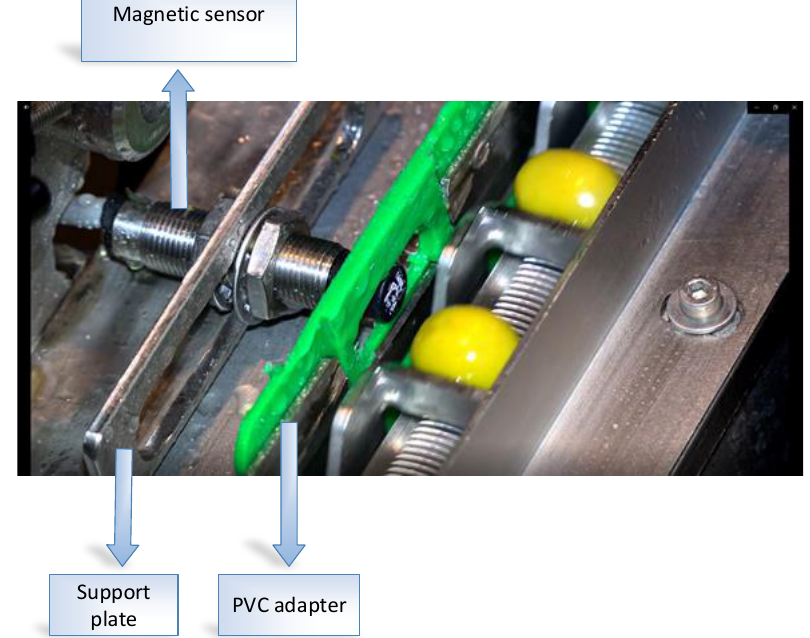
Figure 5. Magnetic sensor used to detect the passage of the pockets in the chain.